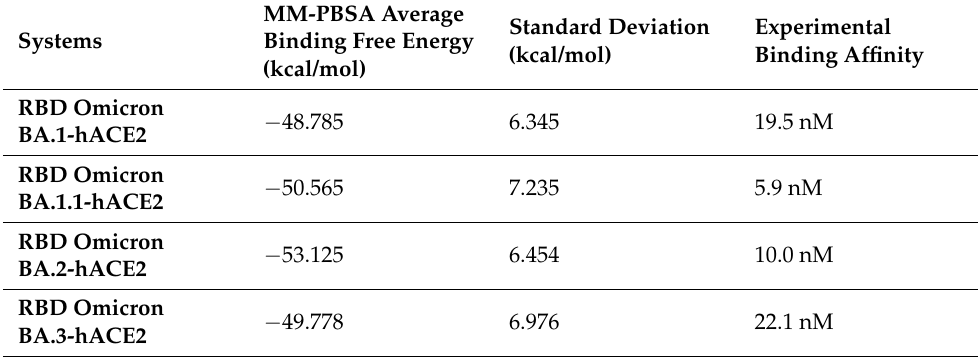
Table 3. MM-PBSA binding free energies for the Omicron RBD-hACE2 complexes *.